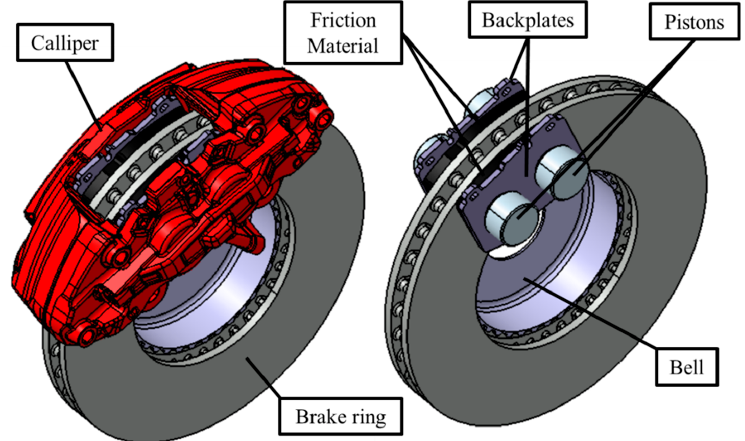
Figure 2. Fixed calliper disc brake system.